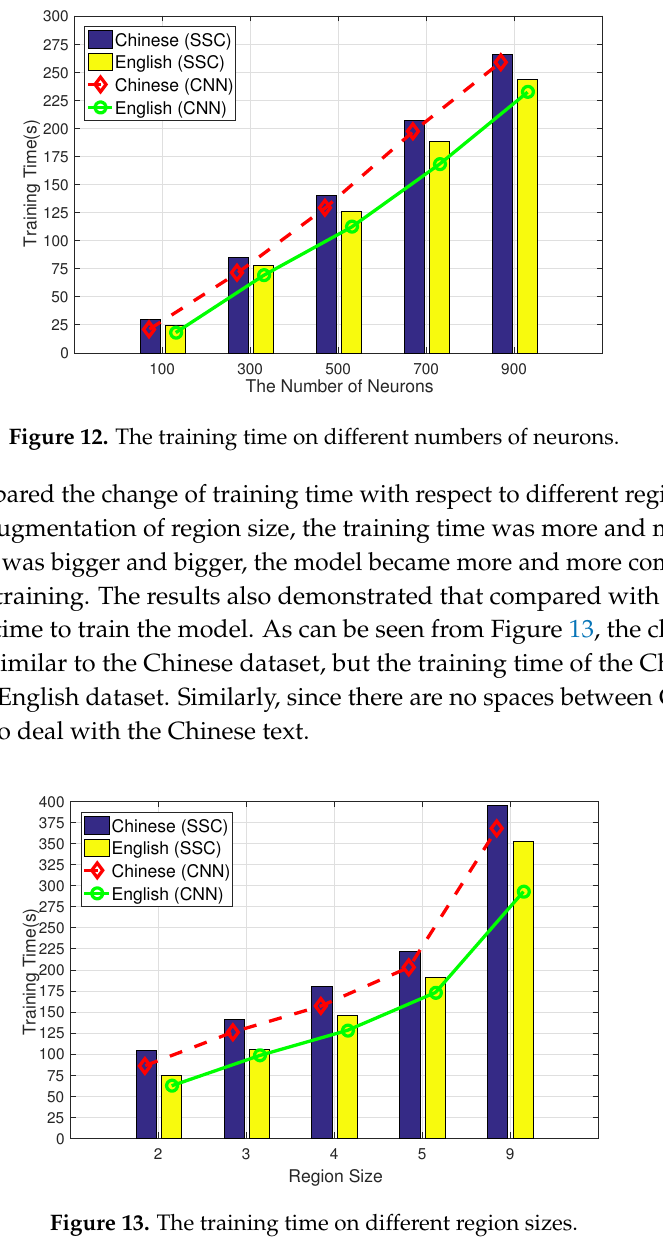
Figure 13. The training time on different region